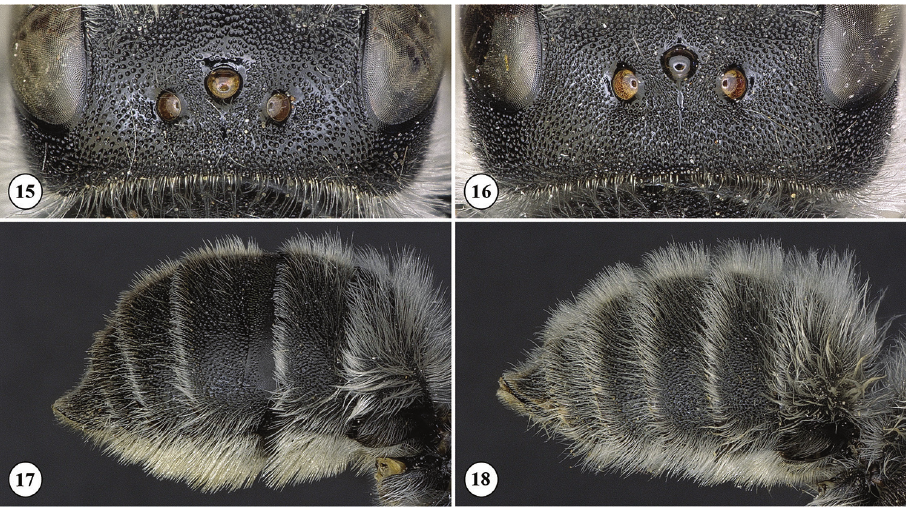
Figures 15–18. Morphological differences in the female sex between Hoplitis mucida (left) and H. stecki (right) (see Table 2): 15–16 Vertex 17–18 Pilosity of tergal